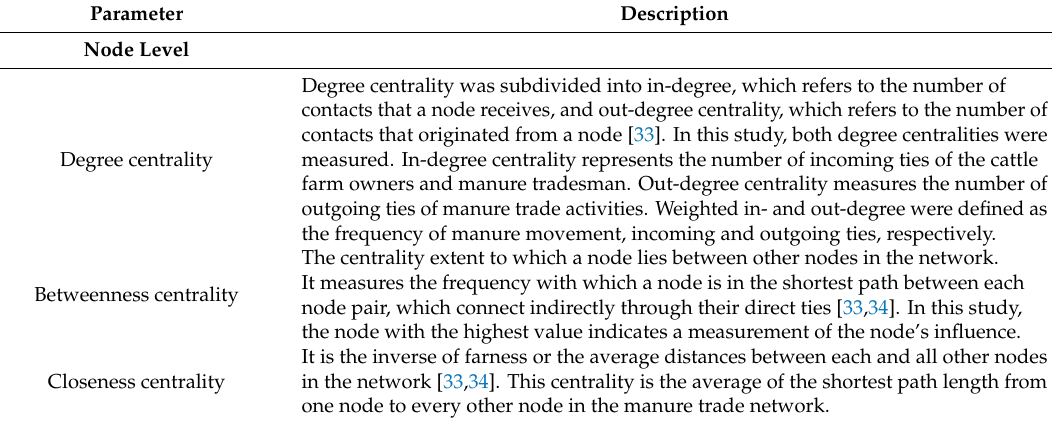
Table 1. Description of the network parameters used in this